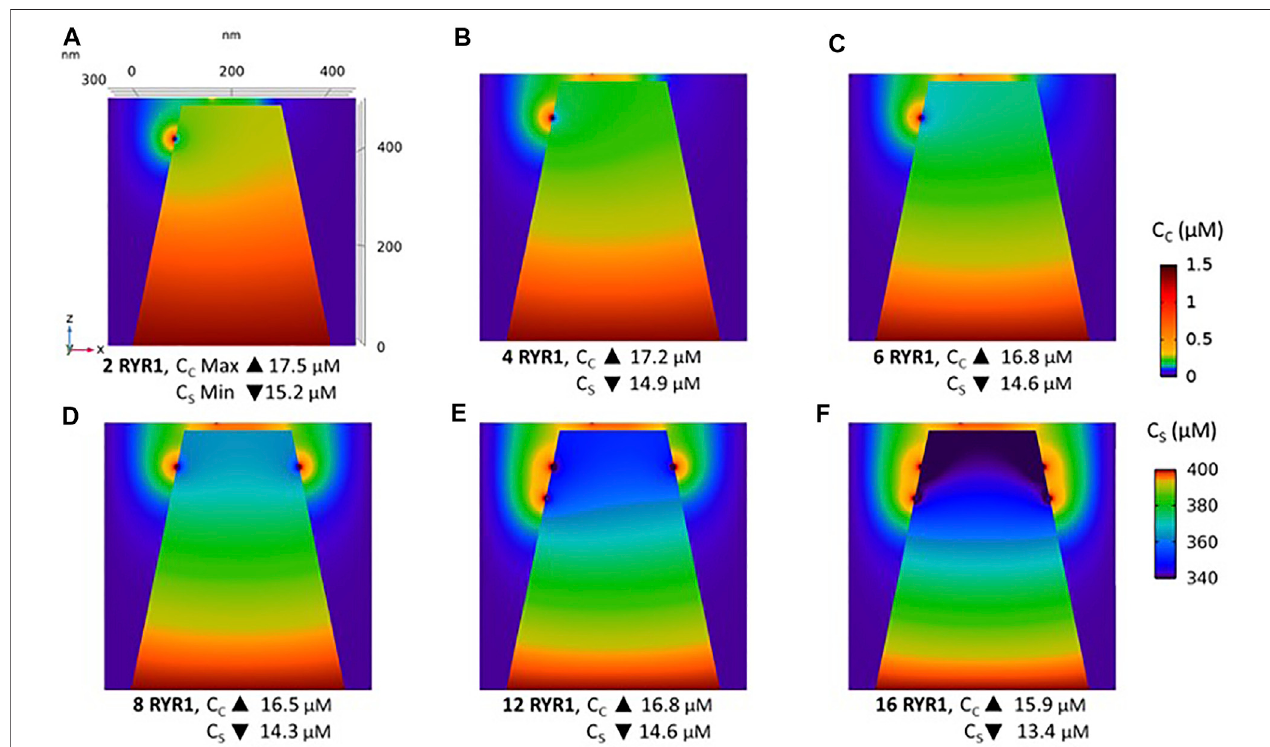
FIGURE 7 | Cross-section of the Ca 2+ pro fi les in the junction, in the cytosol adjacent to the junction and in the sub-PM ER during microdomain formation (A – D) microdomains created by the opening of 2, 4, 6 and 8 RYR1. Local depletion of ER Ca 2+ provokes the opening of the nearby ORAI1s. This situation corresponds to the oneshownin Figure5 . (E,F) microdomainscreatedbytheopeningof12and16RYR1,respectively.ThesecondclusterofeightRYR1islocateddirectlyunderneaththe fi rstcluster.LocaldepletionofERCa 2+ isnotenoughtoprovokeadditionalopeningofthenearbyORAI1s.Thissituationcorrespondstotheoneshownin Figure6 . Forallpanels,theupperrightbarindicatesthecolourcodeofCa 2+ concentrationinthecytosolwhilethelowerrightbarindicatesthecolourcodeofCa 2+ concentrationin the ER. See Anim.